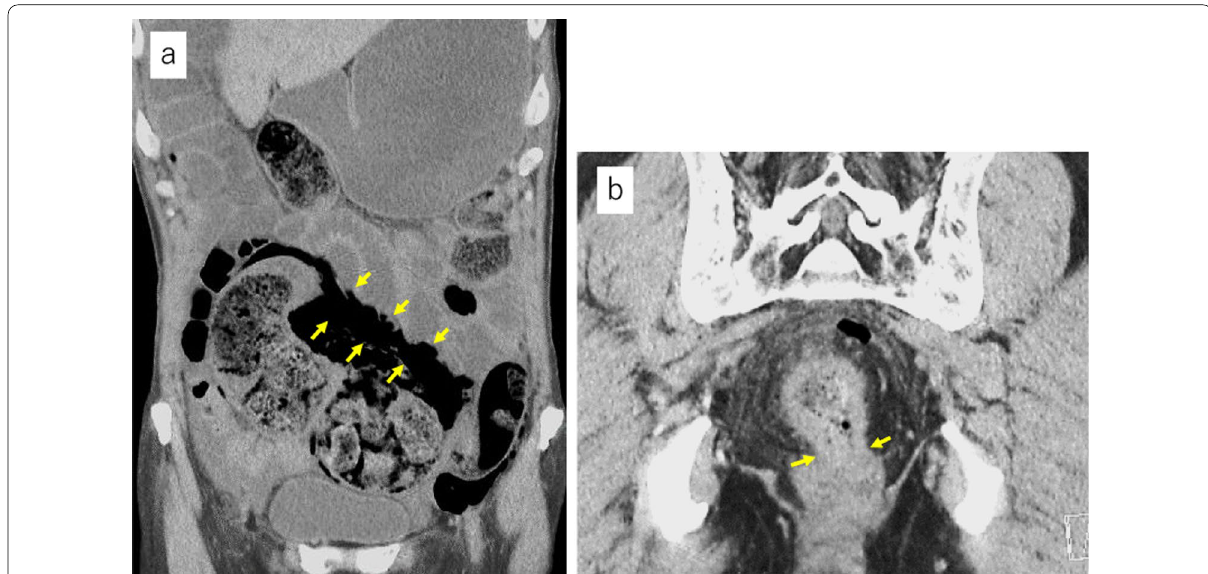
Fig. 4 Computed tomography in case 2. a The gastrointestinal tract was dilated, and there was a large fecal mass inside the sigmoid colon with free air (yellow arrows) around it. b There was wall thickening in the rectum (yellow arrows), and the oral side of the rectum was dilated and had a